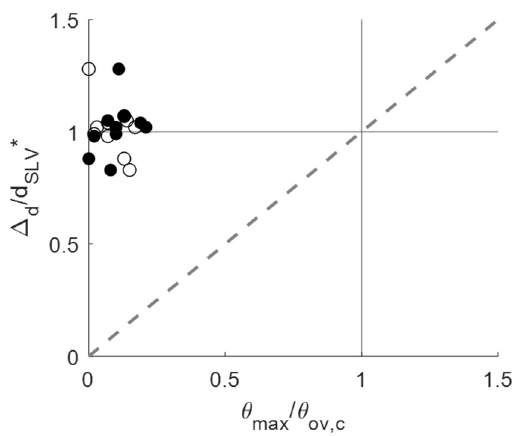
Figure 18. Comparison of the code-based (equivalent static) and rocking (non-linear dynamic) demand-capacity ratios for the different artificial accelerograms, for the church (scaled to a g = 0.48 g).